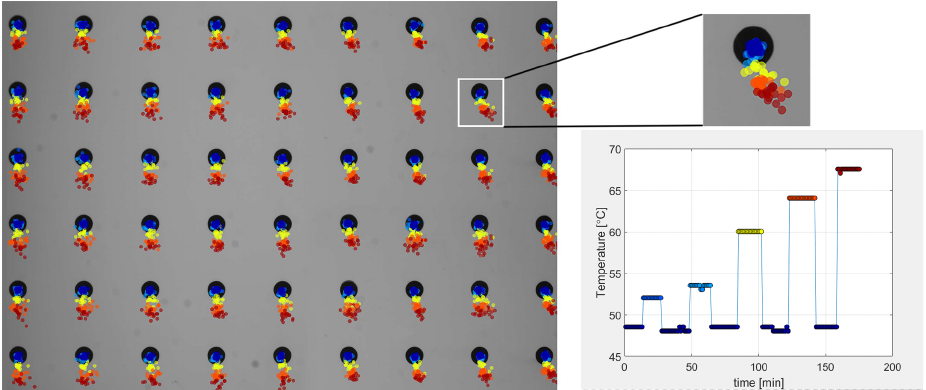
Figure 9. Observed image drift (multiplied × 100) during changes in the ambient temperature; and the measured temperature of the internal camera sensor of the modified camera unit. The hysteresis in the image drift is no longer